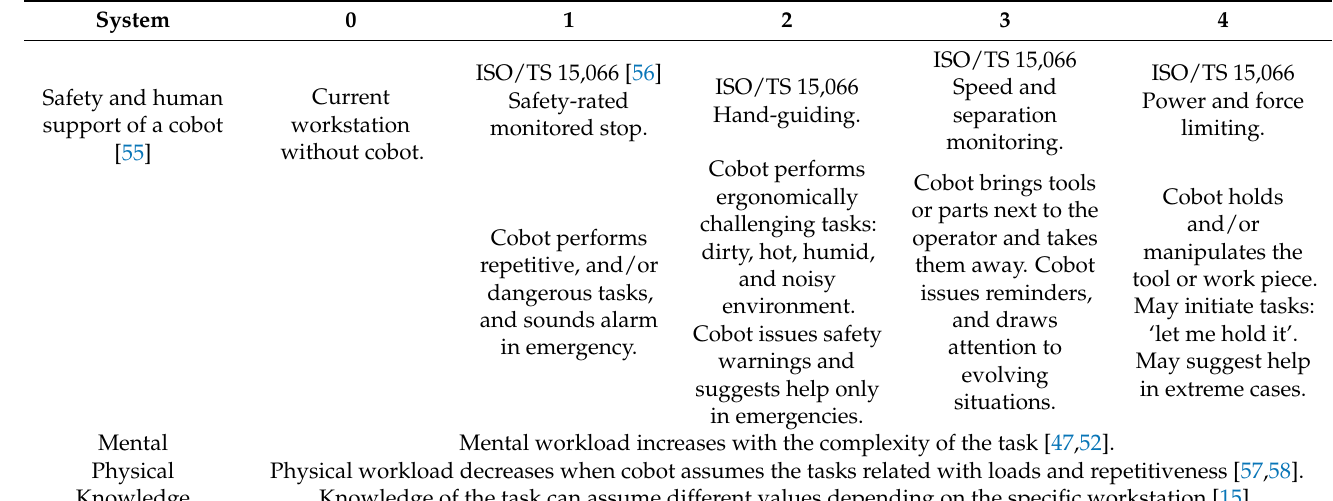
Table 3. Description of competence levels with their influence on the model.